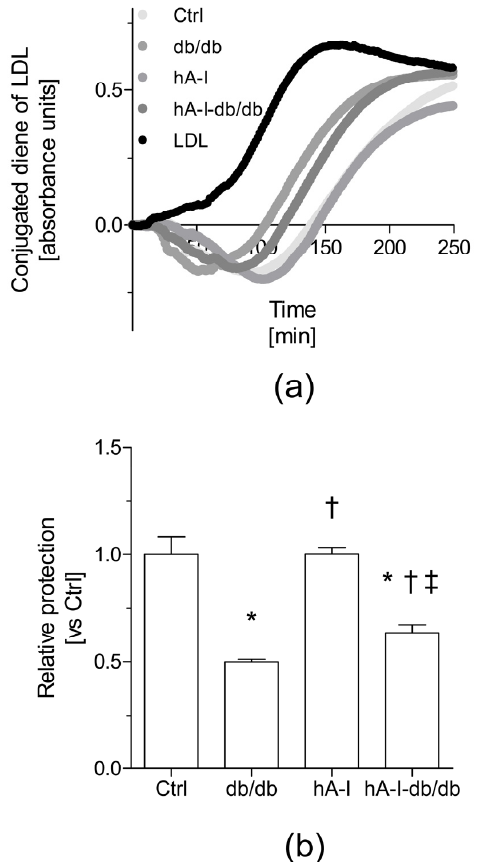
Figure 3. Overexpression of hApoA-I protects low-density lipoprotein (LDL) from ex vivo oxidation in db/db mice. The extent of copper-induced lipid oxidation was evaluated by measuring the formation of conjugated dienes in HDL + LDL mixtures. The results are reported as the lag phase of conjugated diene formation kinetics, which are presented as the relative lag phase to the kinetics of LDL oxidized without HDL (oxLDL). ( a ) Representative diene formation curves of human LDL co-incubated with HDL isolated from the different mouse groups in the presence of 2.5 μ M Cu 2 SO 4 at 37 °C. The kinetics of LDL oxidation are shown after subtracting the kinetics of HDL activity in the absence of LDL. ( b ) HDL antioxidant activity toward the LDL oxidative modification. For calculations, the mean lag time of oxLDL (52 min) was set to a normalized value of 1 arbitrary unit. The results are presented as the means ± standard errors of three independent pools of HDL obtained from 3–4 individual mice per group. Differences between mean values were assessed using the nonparametric Kruskal–Wallis test followed by Dunn’s post-test or an ANOVA followed by the Newman–Keuls post-test, as appropriate; differences were considered significant at p < 0.05. Specifically, * p < 0.05 compared with the Ctrl group, † p < 0.05 compared with db/db mice, and ‡ p < 0.05 compared with hA-I mice. Abbreviations used: Ctrl, control mice; db/db, db/db mice; hA-I, hApoA-I-transgenic mice; hA-I-db/db, hApoA-I-overexpressing db/db